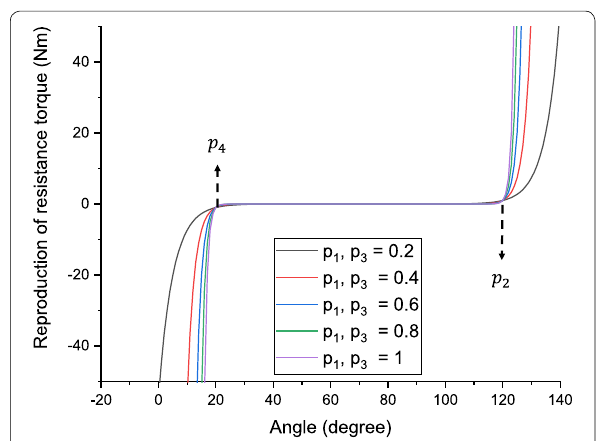
Fig. 3 Example of resistance torque graph of joint resistance torque with respect to joint angle